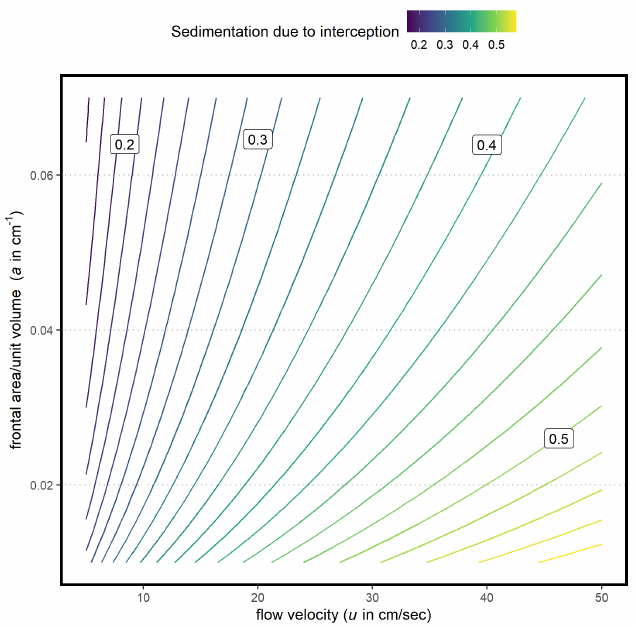
Figure 5. Estimated portion of sedimentation due to interception for 40µm particles under typ- ical marsh vegetation and flow conditions. Although Q c < Q s for much of the parameter space, interception dominated in high flow, low collector density